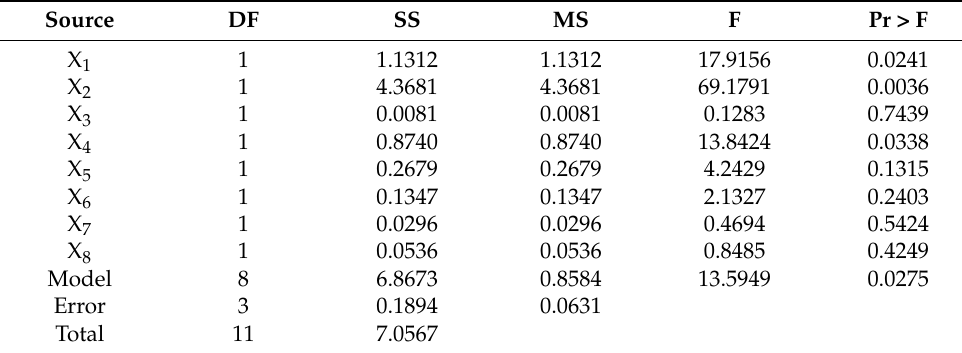
Table A1. Analysis of variance for PBD experiment.